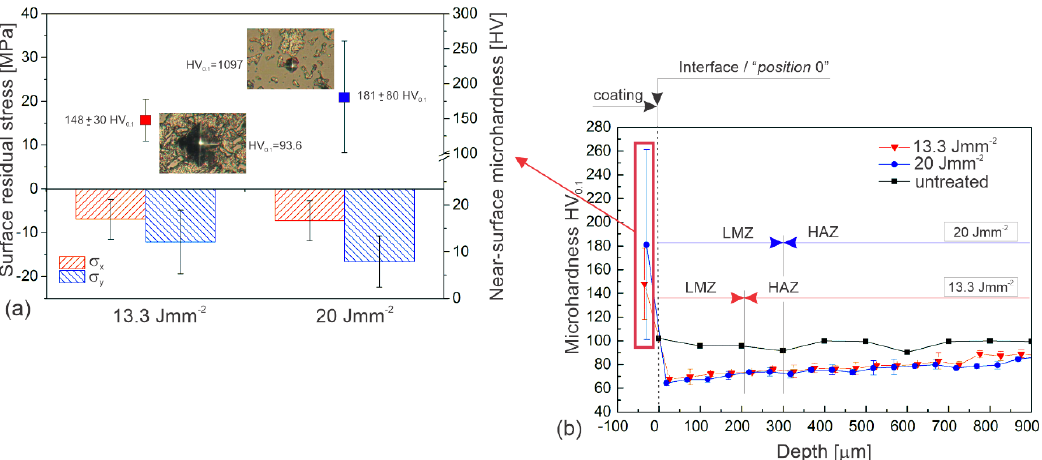
Figure 6. ( a ) Comparison of surface residual stresses and near-surface microhardness in the LSA samples (Inset: HV indentations on the specific region showing the reason for high microhardness deviation) and ( b ) through-depth microhardness profiles.